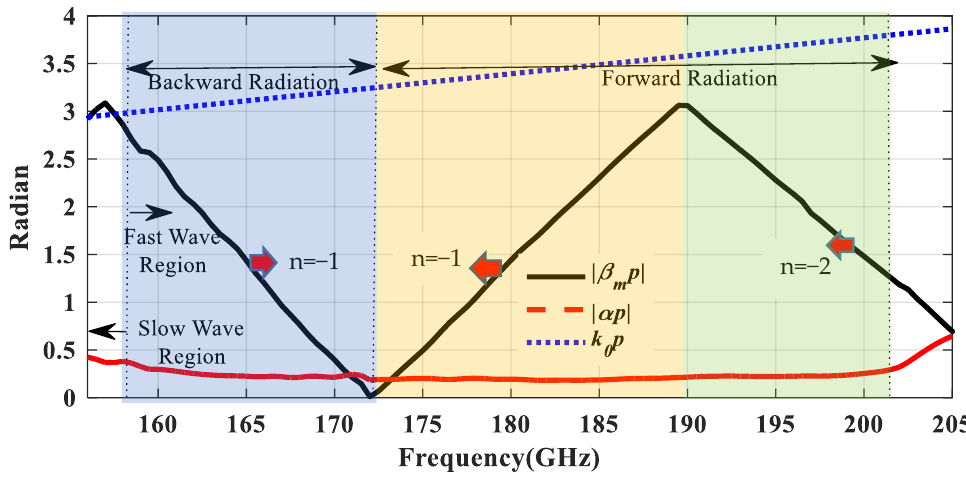
Figure 2. Dispersion curve of the optimized unit-cell with dimensions indicated in Figure 1.